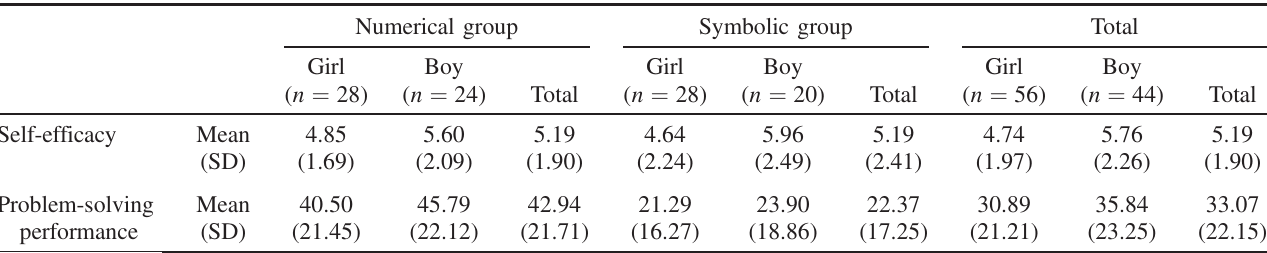
TABLE III. Scores for the self-efficacy of students in solving physics problems and their problem-solving